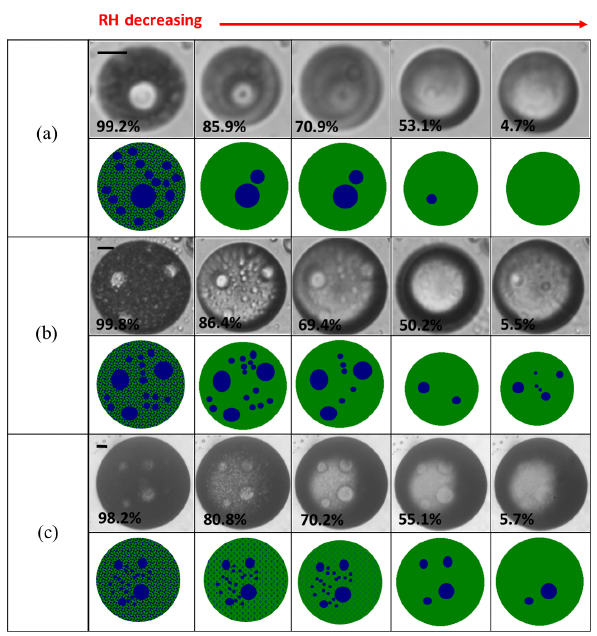
Figure 1. Optical images and illustrations of three diesel fuel SOA particles taken while the RH was decreased. Illustrations are pro- vided to help interpret the optical images with green color represent- ing the organic-rich phase and blue color representing the water-rich phase. The numbers under the optical images indicate the RH. The length of the scale bar is 10µm.